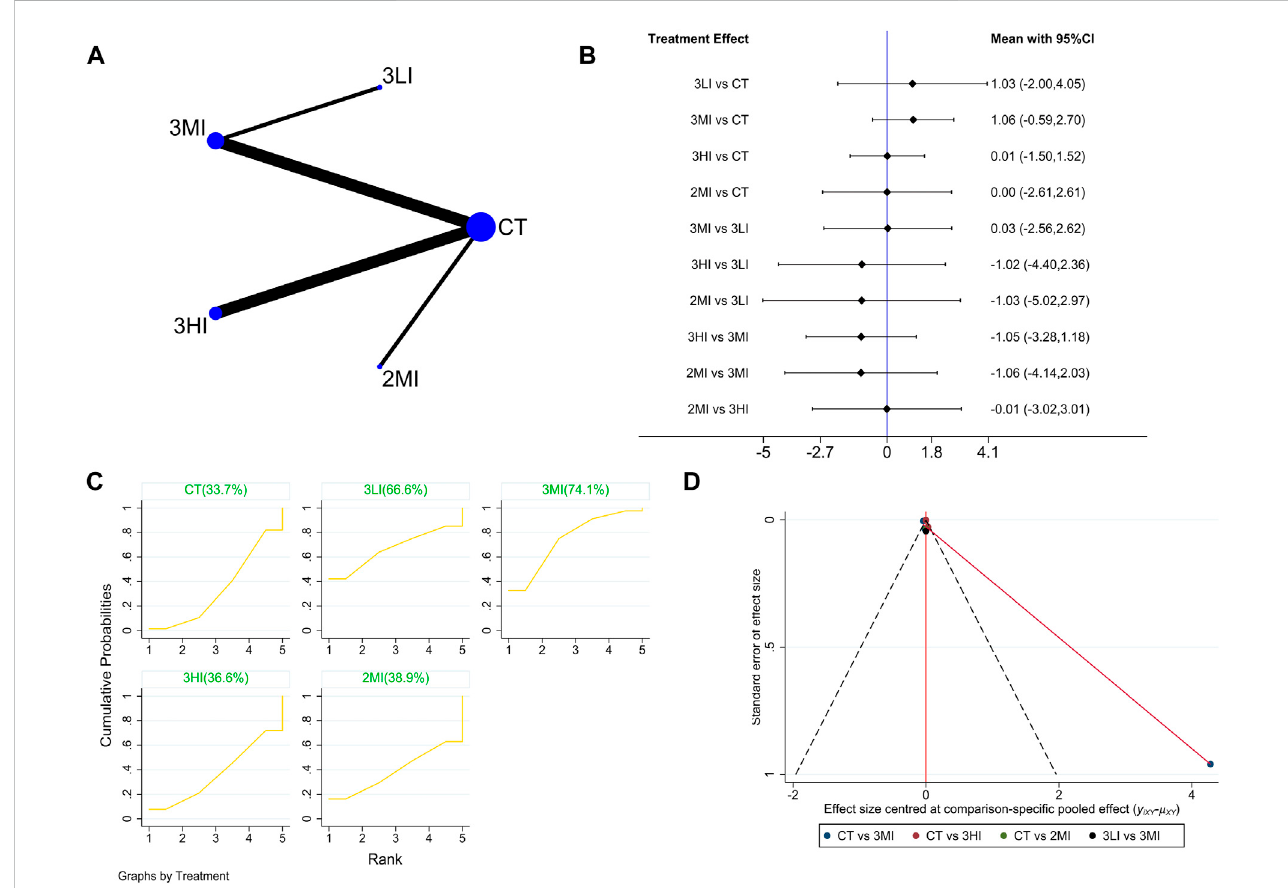
FIGURE 5 Network meta-analysis results forTroch BMD. (A) Network evidence diagram; (B) forest plot; (C) the fi gure of cumulative probability ranking; (D) funnel